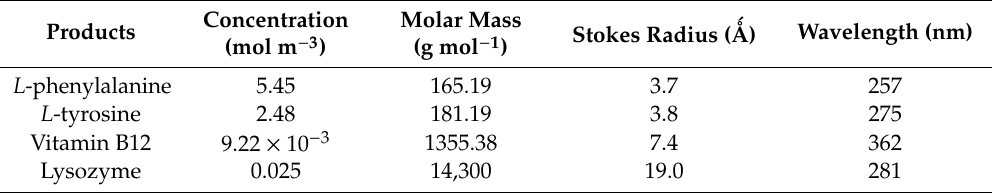
Table 1. Information on the molecules used for experimental